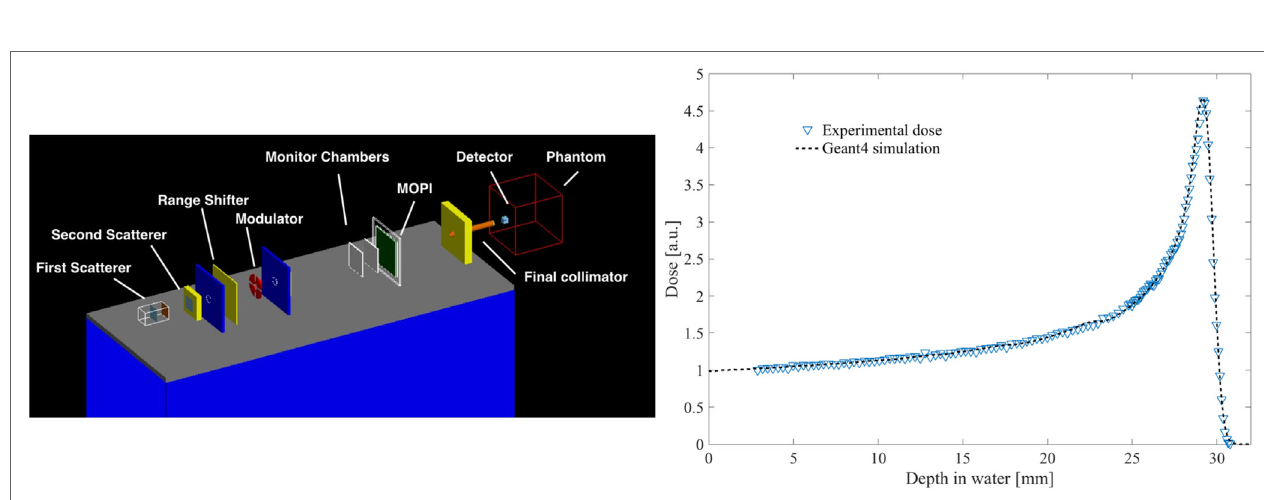
FIgURe 6 | Screenshot from the Hadrontherapy application with the complete simulation of the CATANA proton therapy beamline (left); comparison between and experimental and simulated pristine Bragg peaks (right).